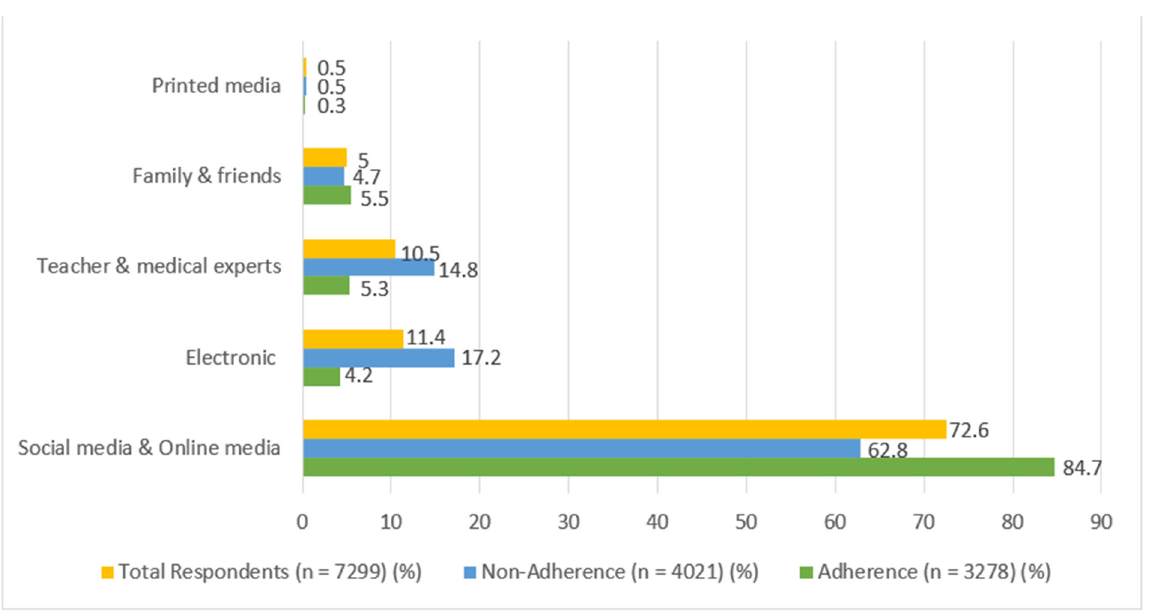
Figure 2. COVID-19 Vaccine Information